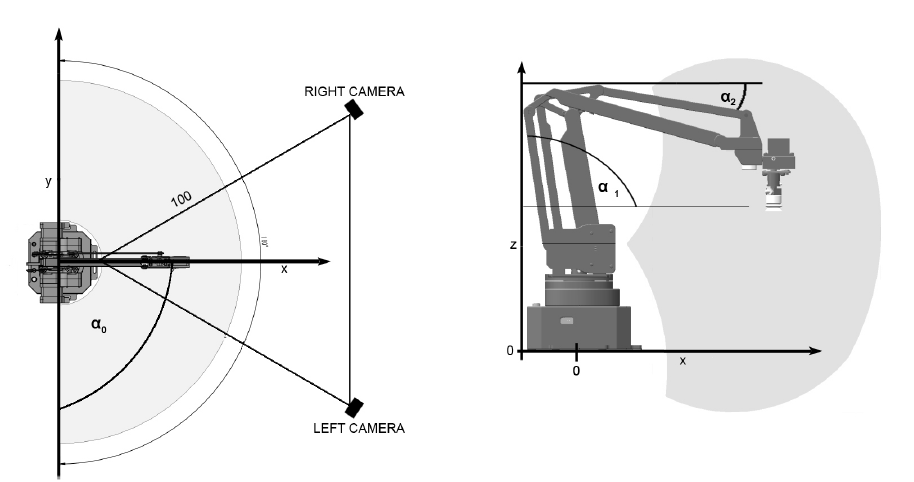
Figure 1. Robot geometry, coordinates: x , y , z , angles: α 0 , α 1 , α 2 ; the placement of cameras during the